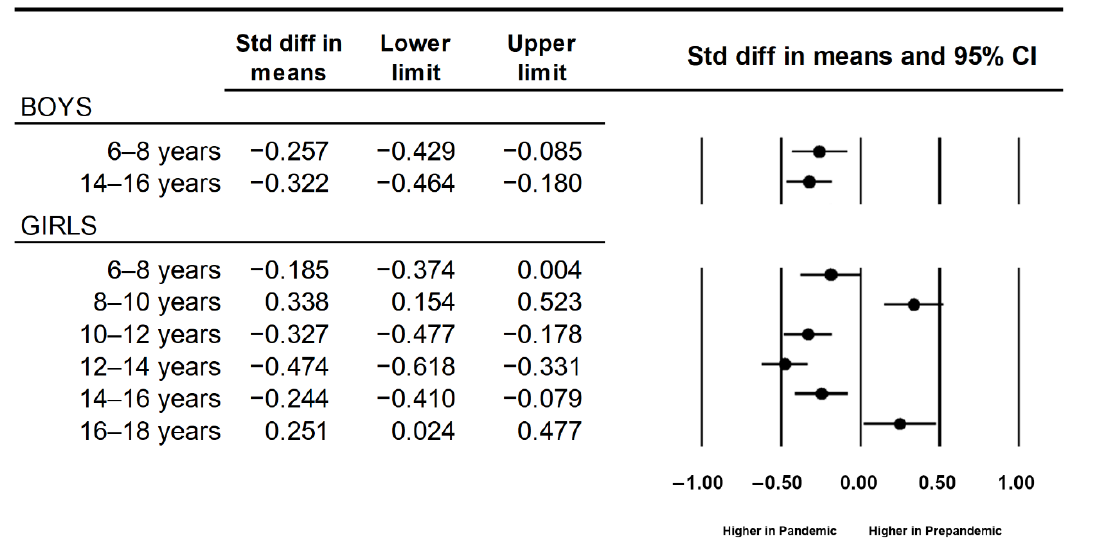
Figure 5. Prevalence of body mass index categories for boys ( A ) and girls ( B ) before and during the pandemic.